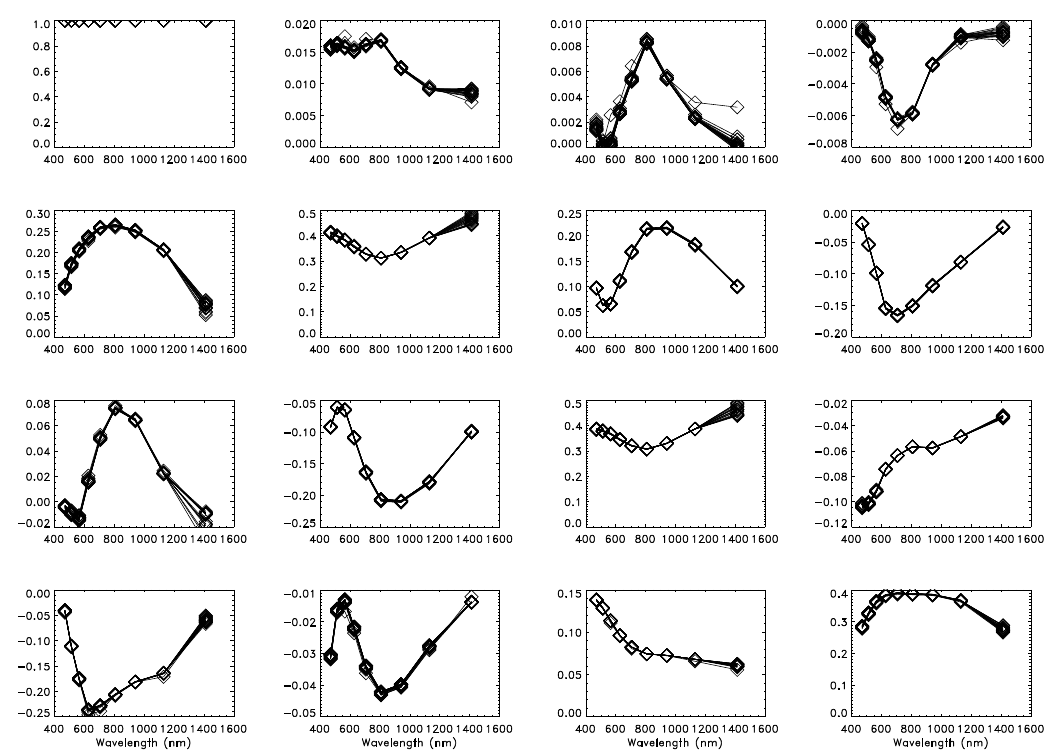
Figure 3: A schematic representation of the wavelength variation of the Mueller matrix of the DST. In each box the wavelength dependence of the value of the matrix element is plotted from 400 – 1600 nm. What is important to note is that the off-diagonal elements, which represent the polarization cross-talk, approach a value of 0 as the wavelength increases. Image reproduced with permission from Socas-Navarro et al. (2011), copyright by